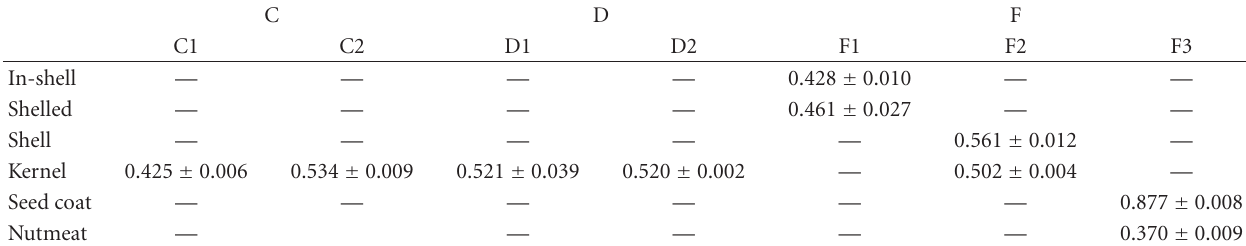
Table 2: Water activity registered for the processor samples ( n = 3, mean ± standard